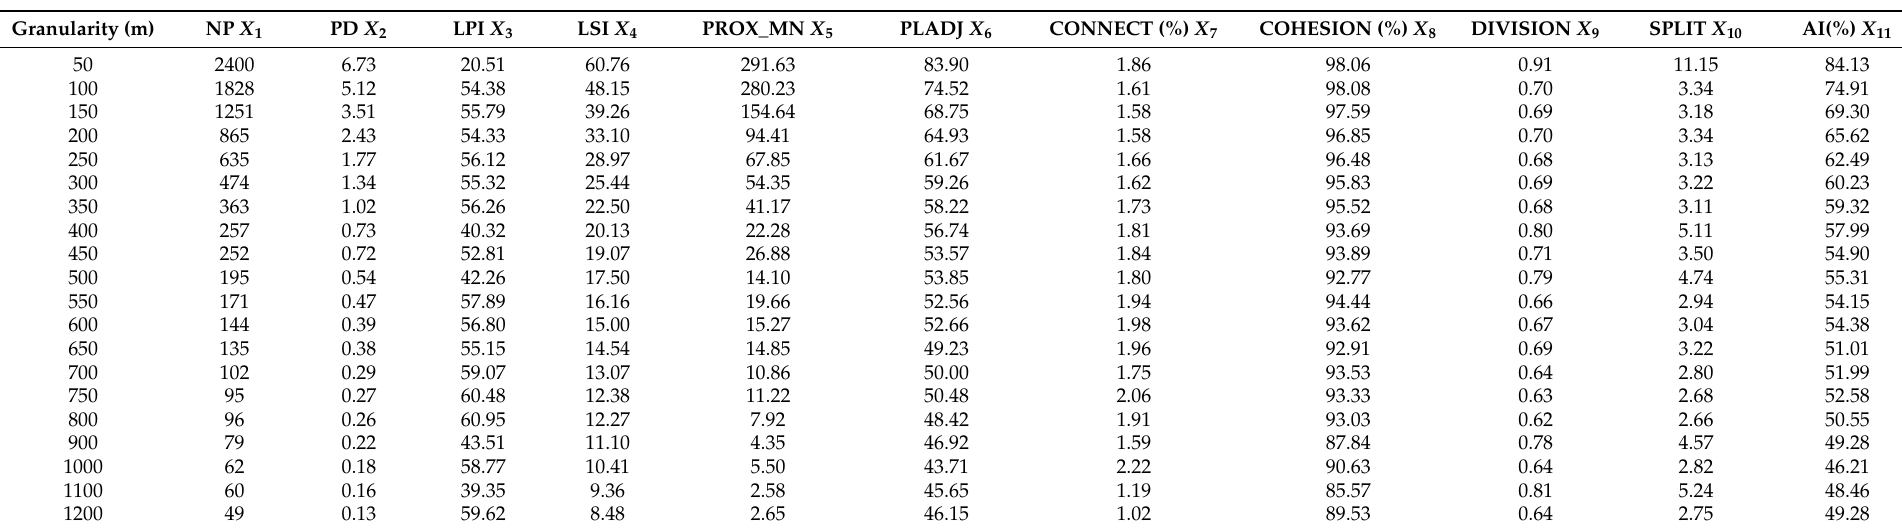
Table 4. Statistics of landscape-pattern index